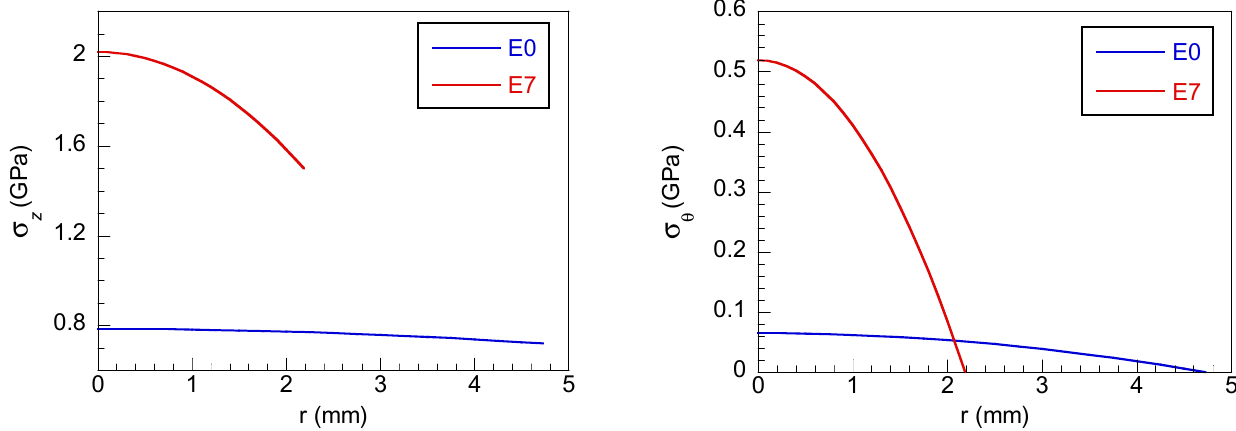
Figure 16. Stress distribution of σ z ( left ) and σ θ ( right ) along the transversal necking surface in steel E0 and E7. Once the distribution of stresses along the minimum neck section is known, and considering that the shear stresses are null by symmetry, it is possible to obtain the stress triaxiality distribution along the radius r of the neck section. The stress triaxiality t (3) is the ratio between the hydrostatic stress σ h (4) and the equivalent von Mises stress σ eq (5).